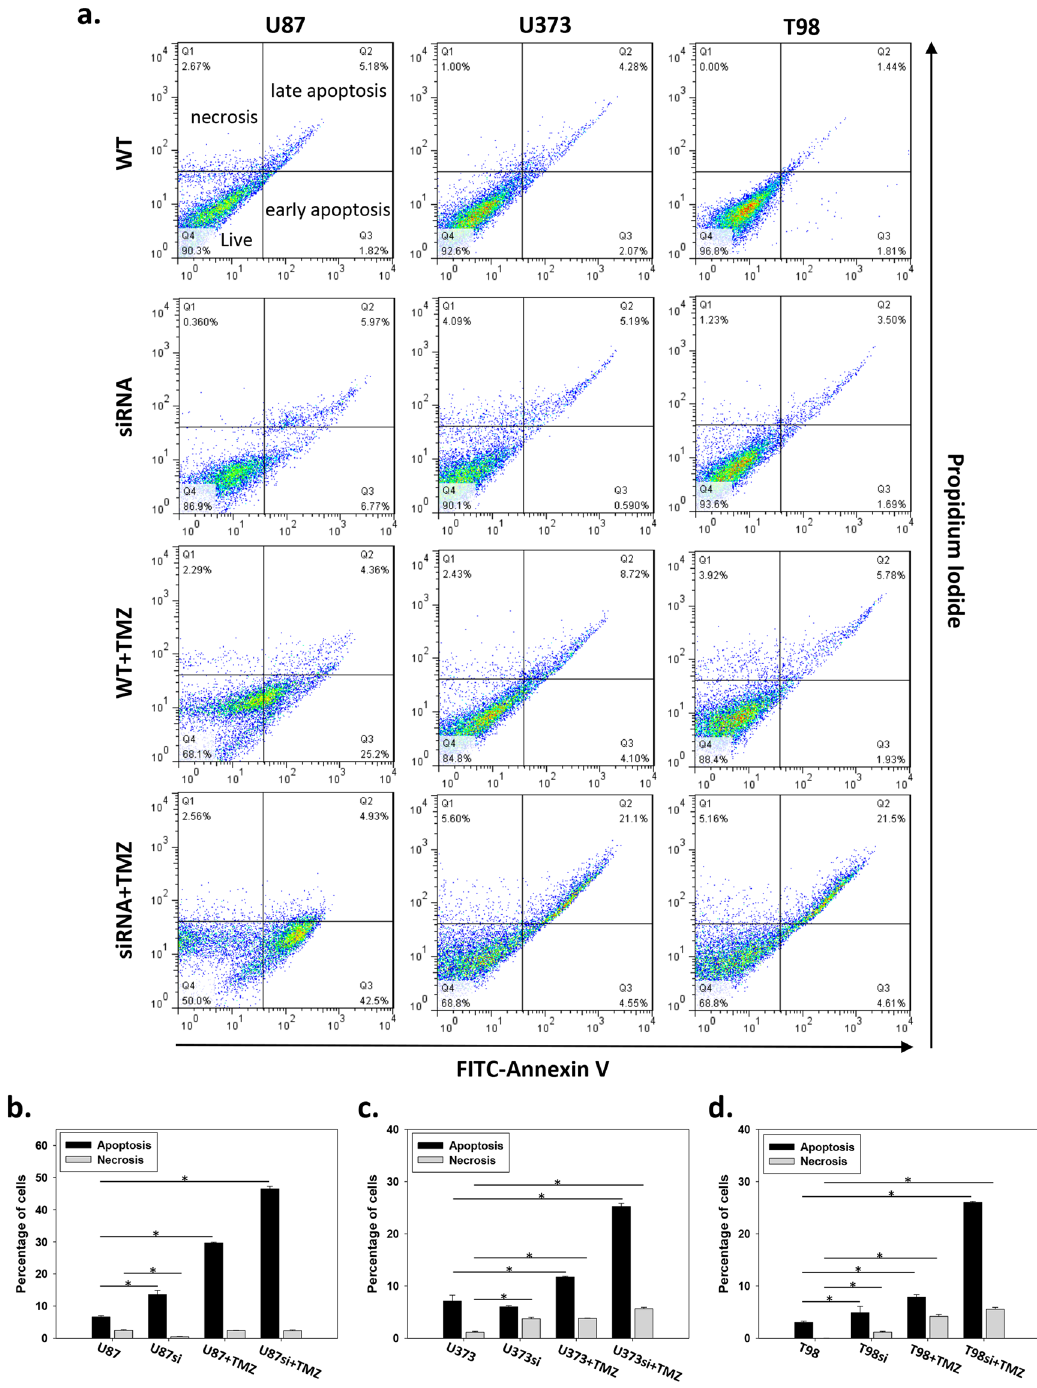
Figure 6. TMZ induced apoptosis in U87, U373 and T98 cell lines with TMZ or GADD45A siRNA treatment. U87, U373 and T98 cells were pretreated with or without GADD45A siRNA before TMZ (25 μ g/ml) or DMSO only treatment. The cell apoptosis was examined at day 4 after drug treatment by V-FITC/PI staining and flow cytometry analysis. ( a ) The dot plots shows the percentage of different apoptosis stage. FITC − /PI − , FITC + /PI − , FITC + /PI + , FITC − /PI + was regarded as living, early apoptotic, late apoptotic and necrotic cells, respectively. The quantification of percentage of apoptotic (early + late apoptotic cells) and necrotic cells in U87 ( b ), U373 ( c ) and T98 ( d ). n = 3, * p <